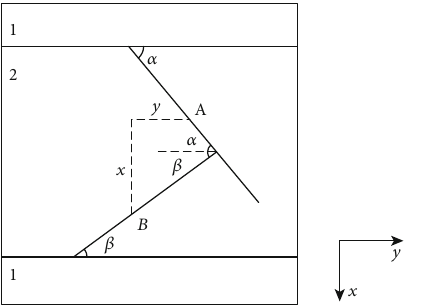
Figure 19: Top view of the relationship between fi bers. Figure 20: Top view of fi ber distance in y